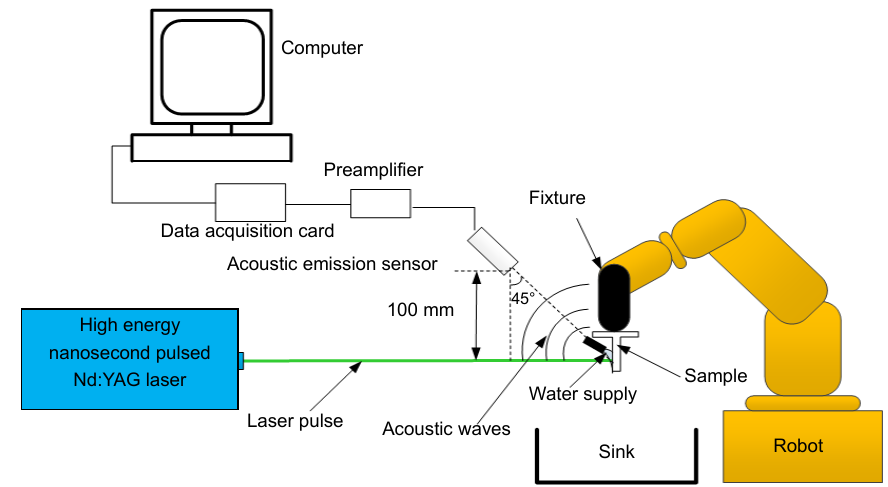
Fig. 1 | Schematic diagram of experimental device.